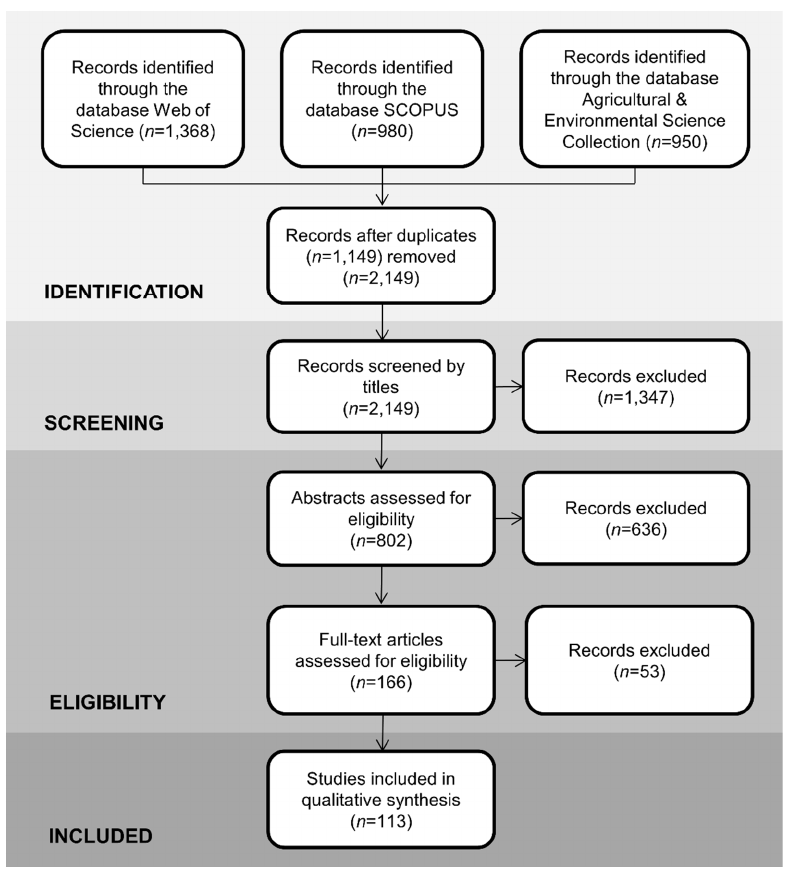
Figure 1. PRISMA literature search flow diagram. The number of studies ( n ) that were identified, screened, retained, or discarded are shown at each stage of the review